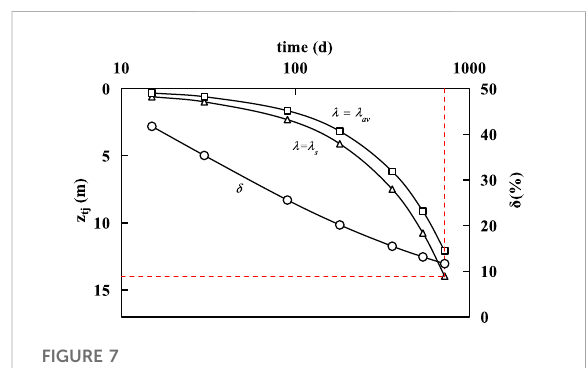
FIGURE 7 Vertical migration depth of chloride ions under different detection standards, δ is the relative deviation between λ av and λ s .